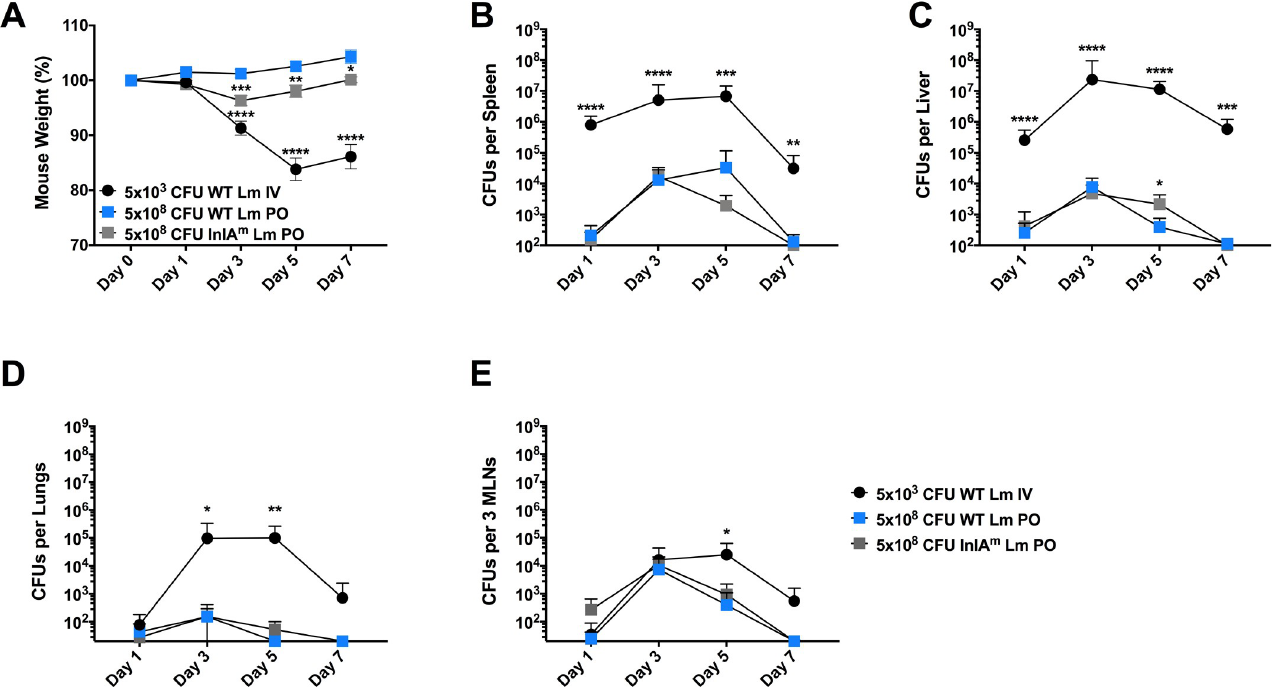
Fig 1. Orally-inoculated mice resist Lm-induced morbidity . C57BL/6J (B6) male and female age-matched mice were infected with WT Lm IV, WT Lm PO, or InlA m Lm PO and analyzed over a time course of infection. (A) Mouse weights as a percent % starting weight were determined at each time point. Data are represented as mean ± SEM, Two-way ANOVA, pooled from 3 experiments, with 8–15 mice per group, � p < 0.05, �� p < 0.002, ��� p < 0.0002, ���� p < 0.0001 between WT Lm PO and indicated groups. In addition, CFUs were determined for each infection at the given time point in the following tissues (B) spleen, (C) liver, (D) lungs, (E) mesenteric lymph nodes (MLNs). Data are represented as mean ± SD, Mann-Whitney t-test, pooled from 3 experiments, with 8–15 mice per group, � p < 0.05, �� p < 0.002, ��� p < 0.0002, ���� p < 0.0001 between WT Lm PO and indicated groups.